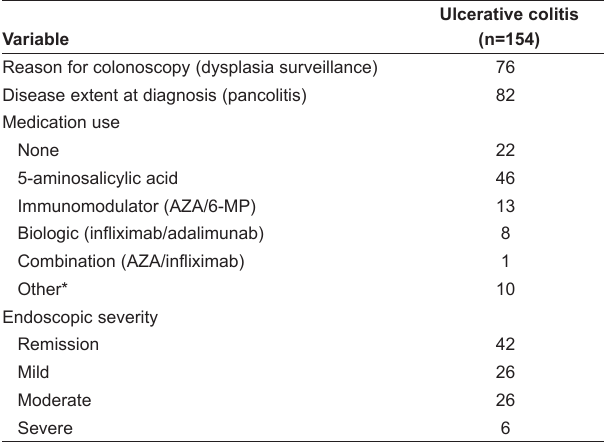
TAble 2 Patient characteristics